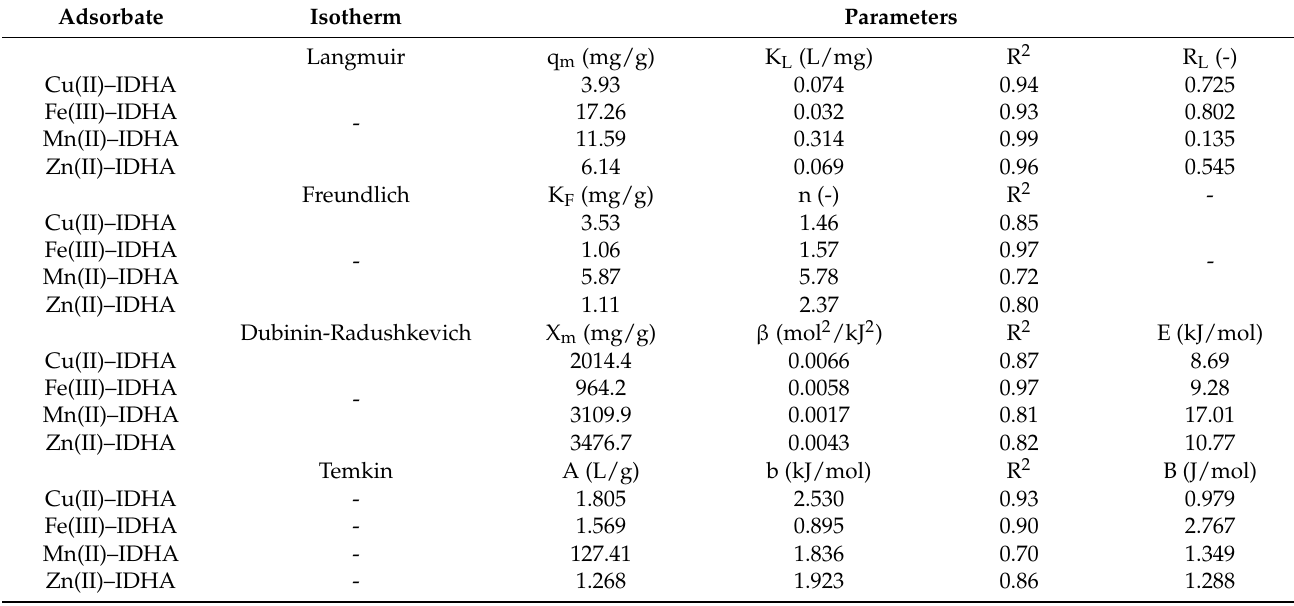
Table 5. Isotherm parameters for Cu(II), Fe(III), Mn(II), and Zn(II) complexes with IDHA onto NaP1CS.